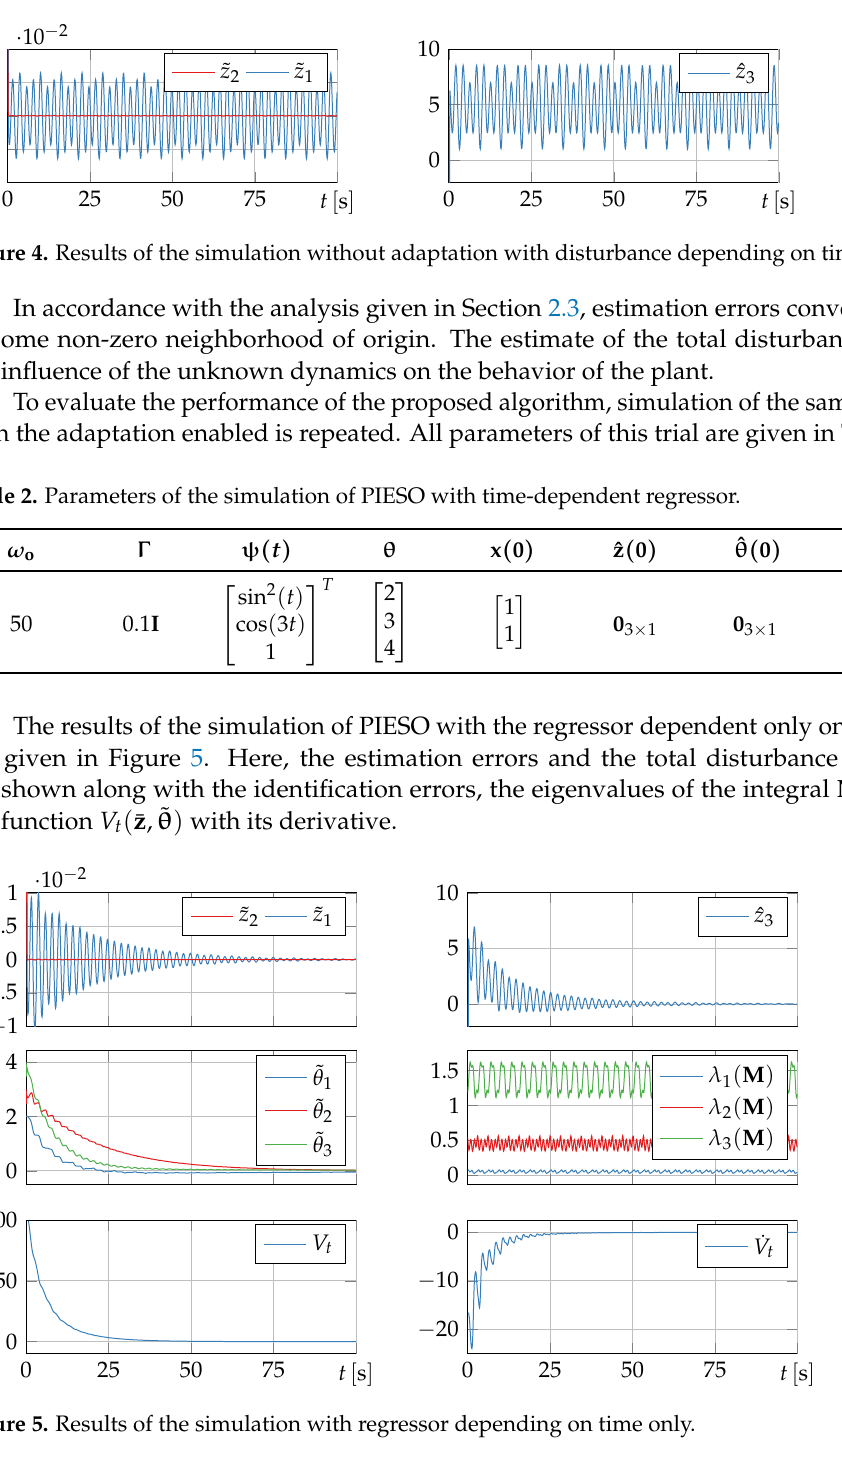
Figure 5. Results of the simulation with regressor depending on time